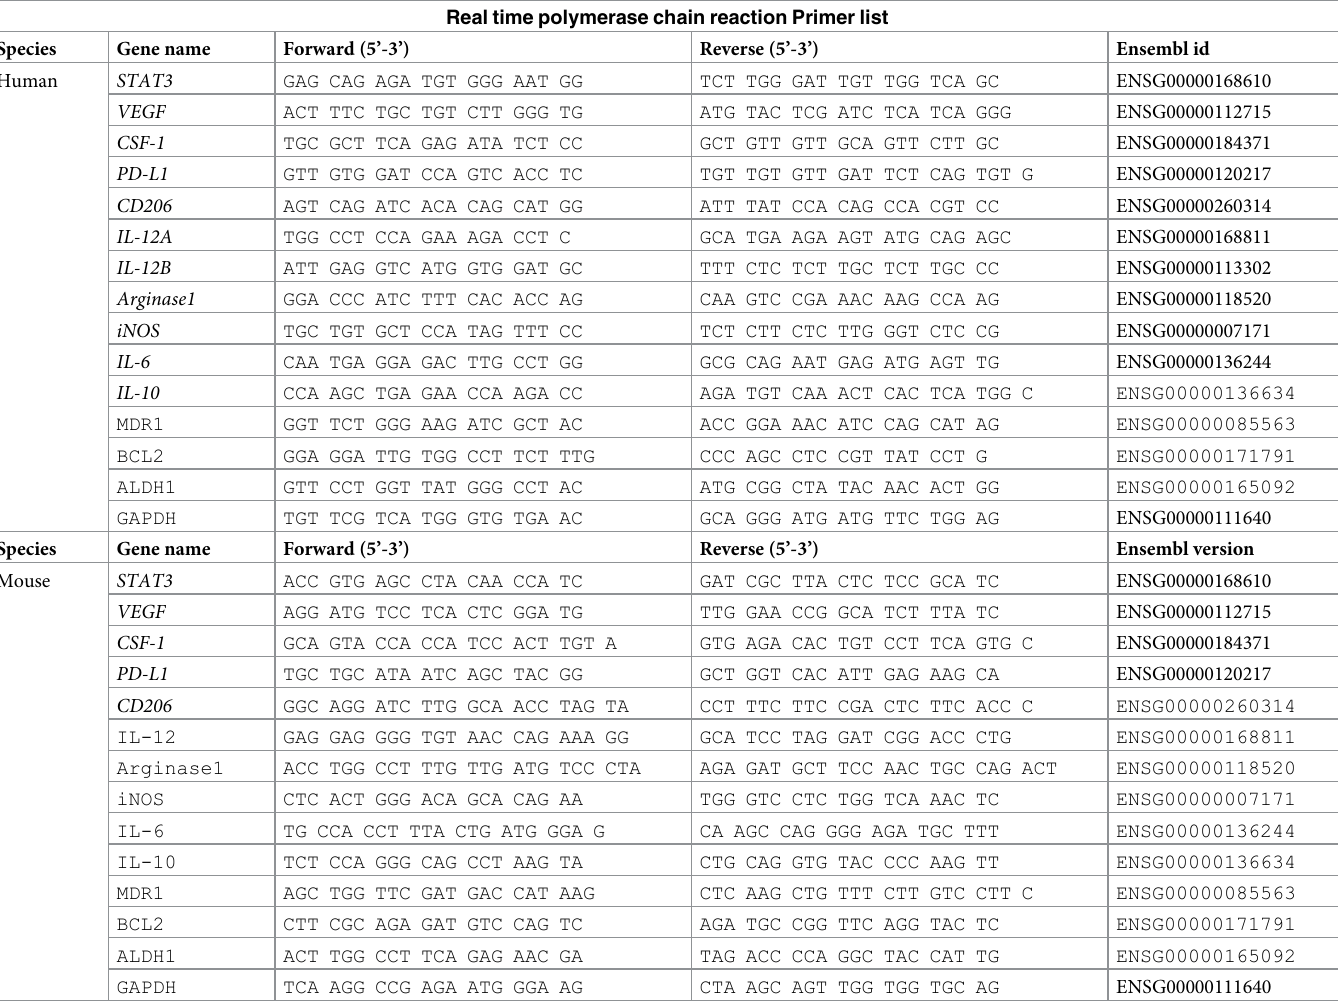
Table 1. RT-PCR primer pairs designed based on sequence information obtained from the Ensembl genomic database